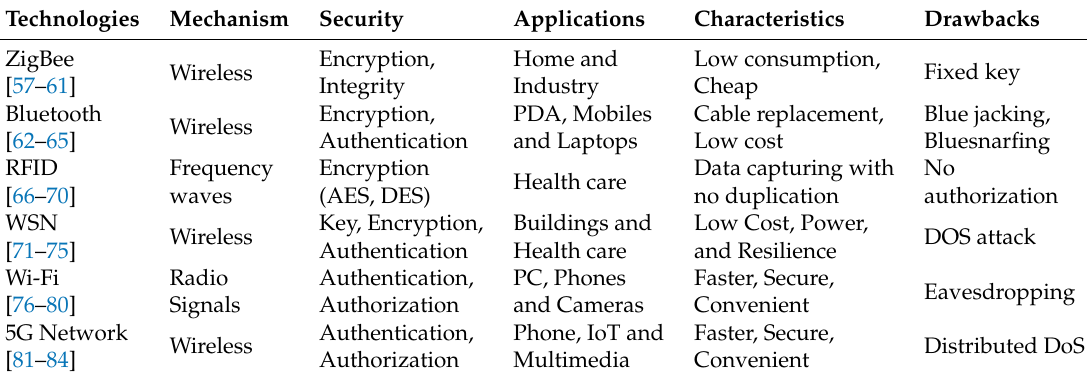
Table 3. Comparison of different communication technologies used in